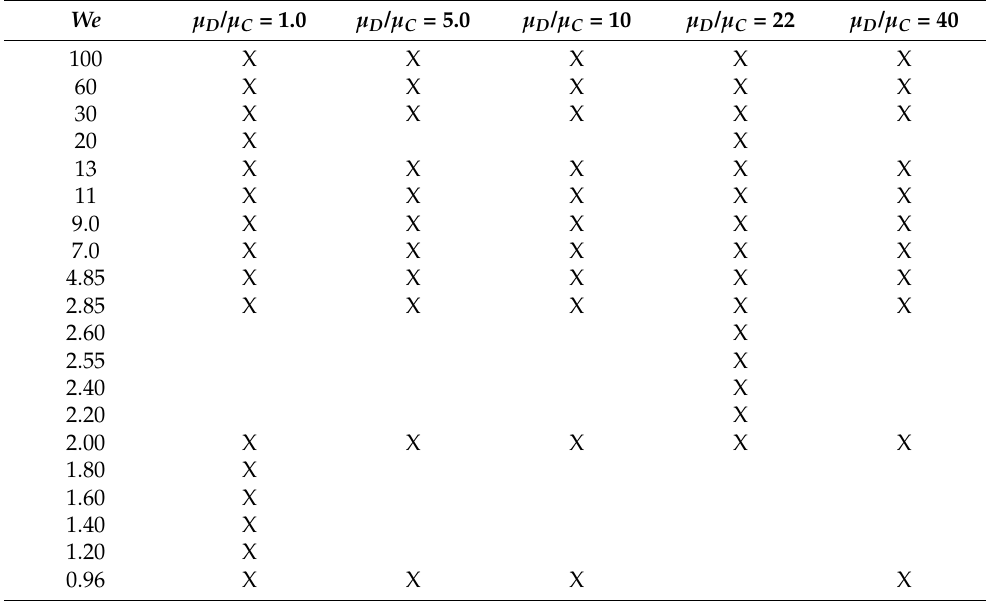
Table 1. Investigated cases (marked